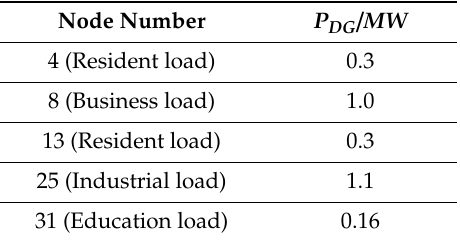
Table 4. Optimized Configuration Results.